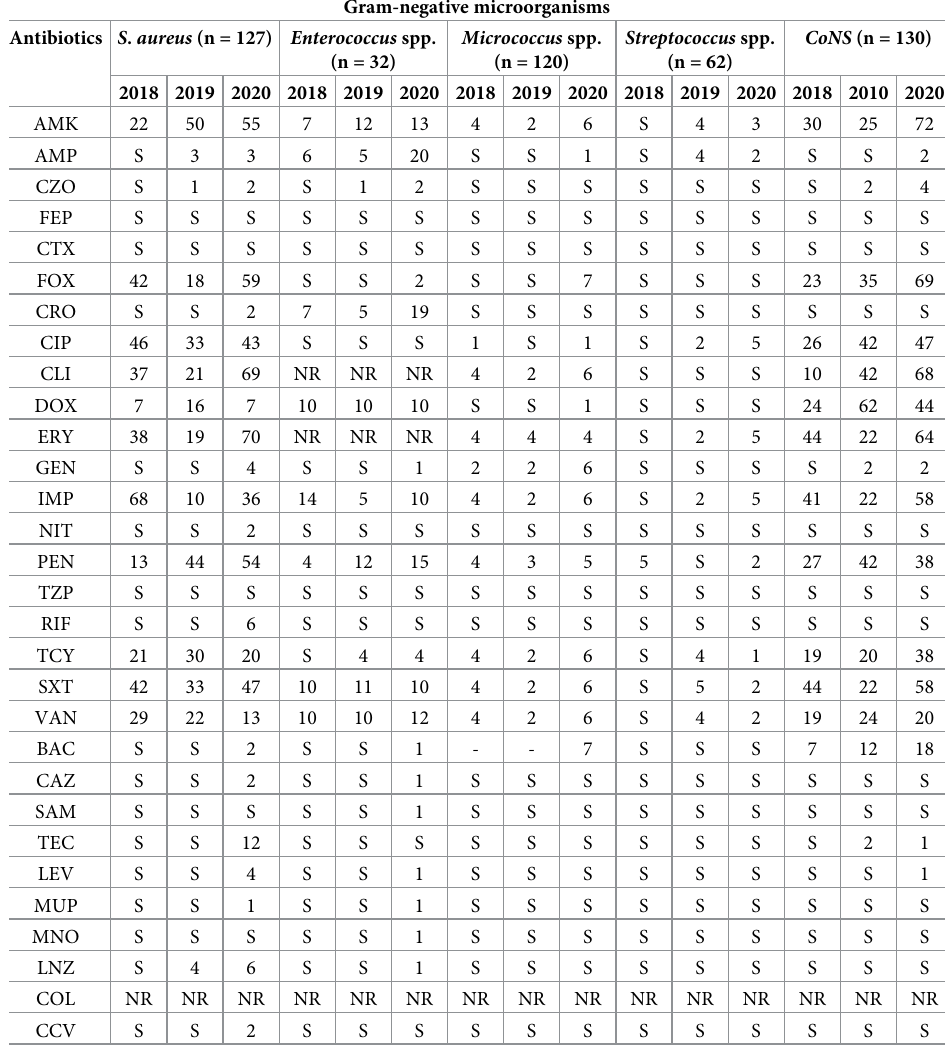
Table 4. The resistance rates of GPB to commonly used antimicrobials (2018–2020). Antibiotics S . aureus (n = 127) Enterococcus spp.